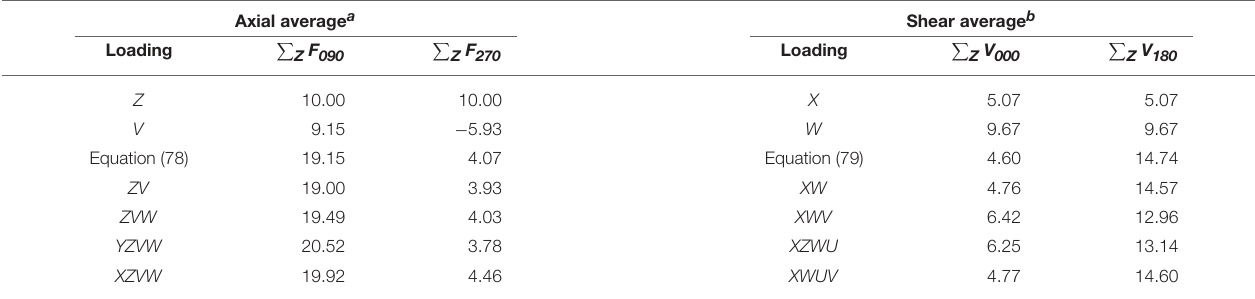
TABLE A1 | Average forces summed from top to bottom along the middle of the vertical sides of a structure with square cross-section, sides L = 25 and height H = 101, with the structure having been subjected to different external loadings. Axial average a Shear average b